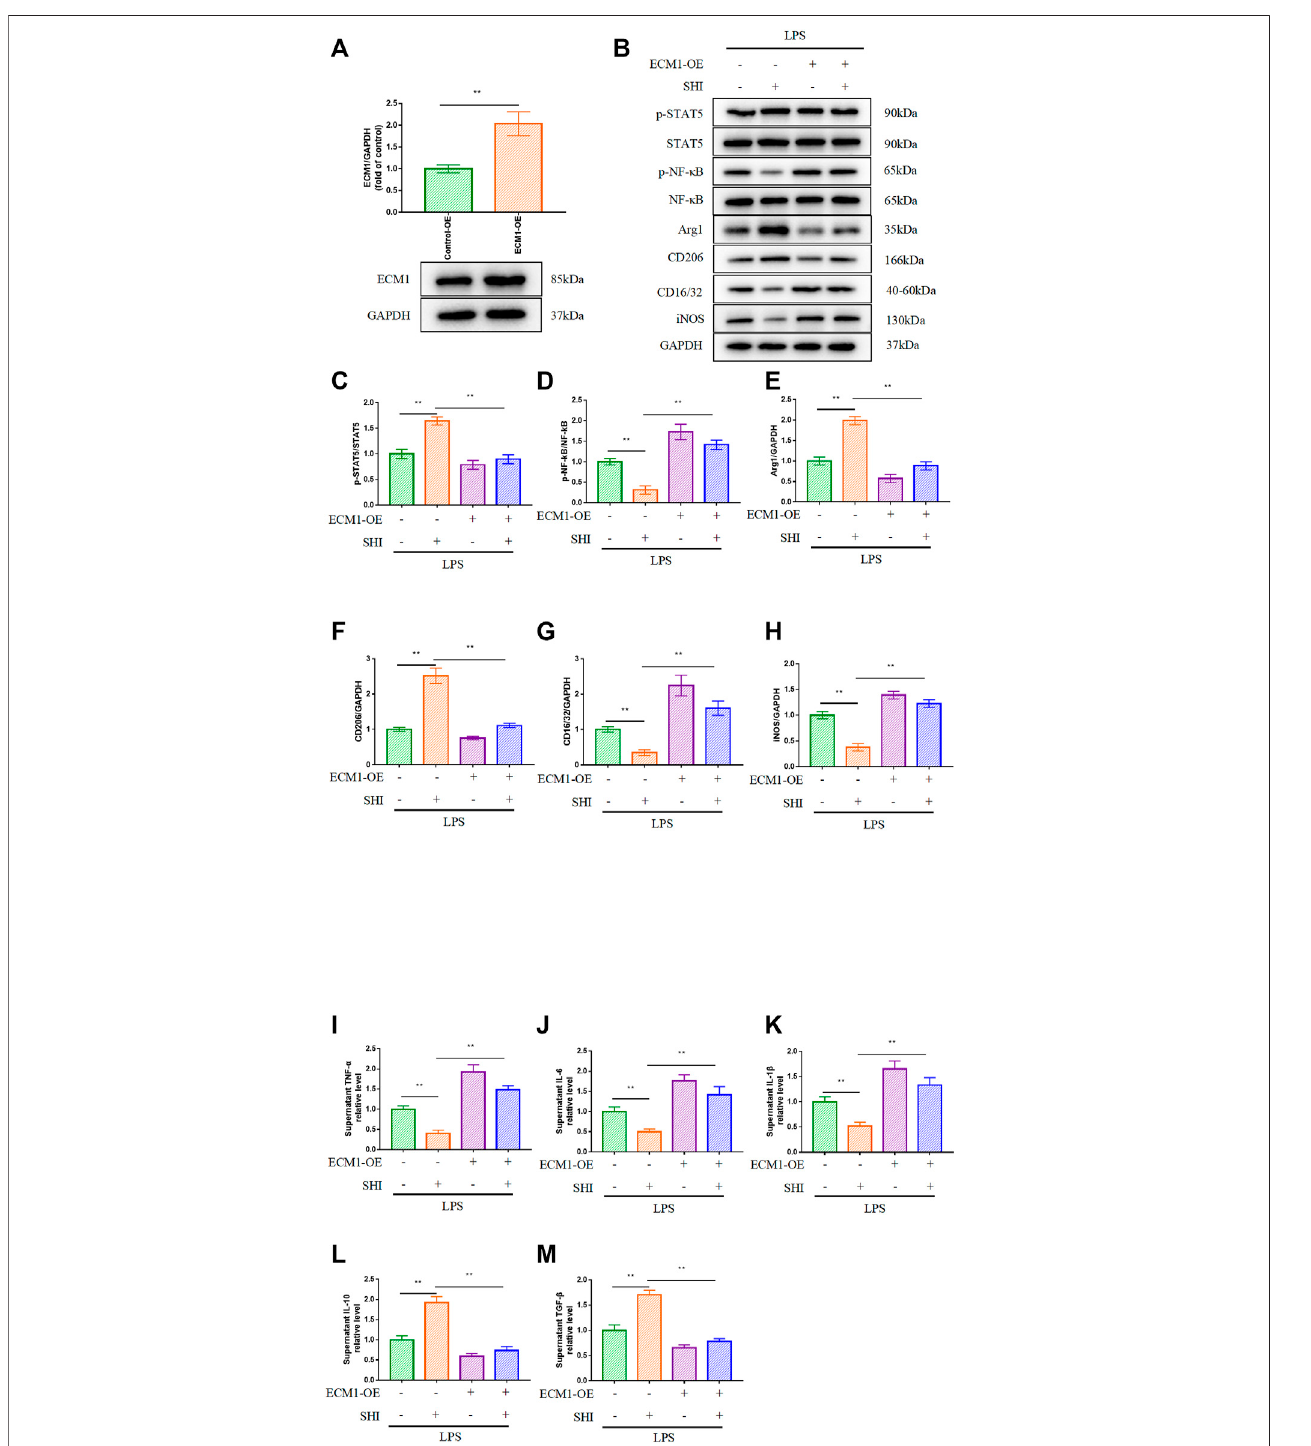
FIGURE 5 | The role of ECM1 in SHI-mediated macrophage polarization. The cells were exposed to ECM1 adenovirus added for 24 h. Afterward, the cells were treated with SHI (2.0 μ g/ml) for 2 h and then stimulated with LPS for 24 h. (A) The transfection ef fi ciency of ECM1 overexpression. (B – H) The protein expression of ECM1, p-STAT5, STAT5, p-NF- κ B, NF- κ B, Arg1, CD206, CD16/32, and iNOS. (I – M) The supernatant levels of TNF- α , IL-6, IL-1 β , IL-10, and TGF- β in LPS-induced RAW264.7 cells. The data are expressed as mean ± SD. Compared with the other group: * p < 0.05, ** p < 0.01.